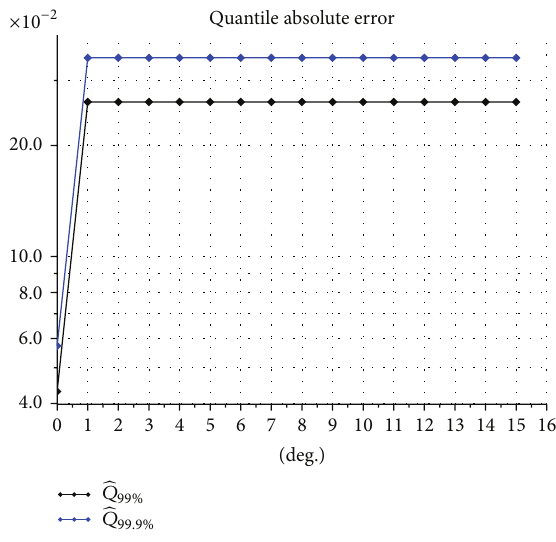
̂𝑄 ̂𝑄 99 % and 99.9 % of